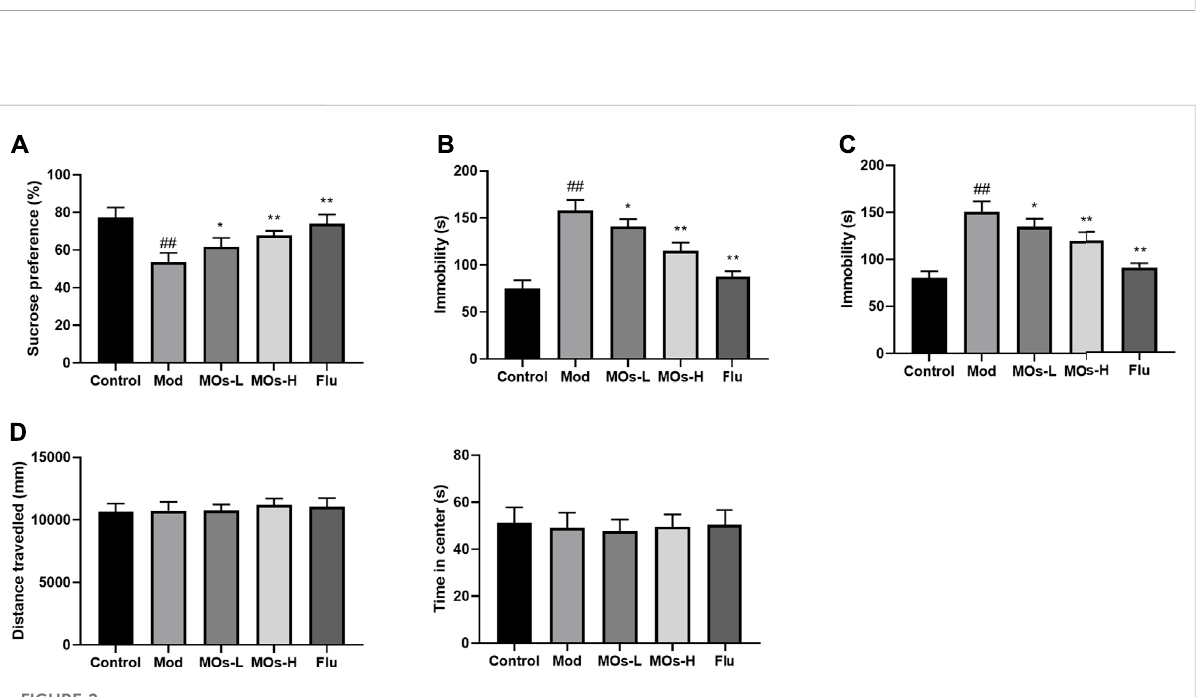
FIGURE 2 MOs block CMS-induced depressive-like behavior. (A) Mean sucrose preference (%) in the sucrose preference test. (B) The duration of immobility during the tail suspension test. (C) The duration of immobility during the forced swim test. (D) Total distance travelled and time spent in the center zone in the open fi eld test. Data are expressed as means ± SD ( n = 10). ## p < 0.01 vs. control; * p < 0.05; ** p < 0.01 vs. Mod; ns, not signi fi